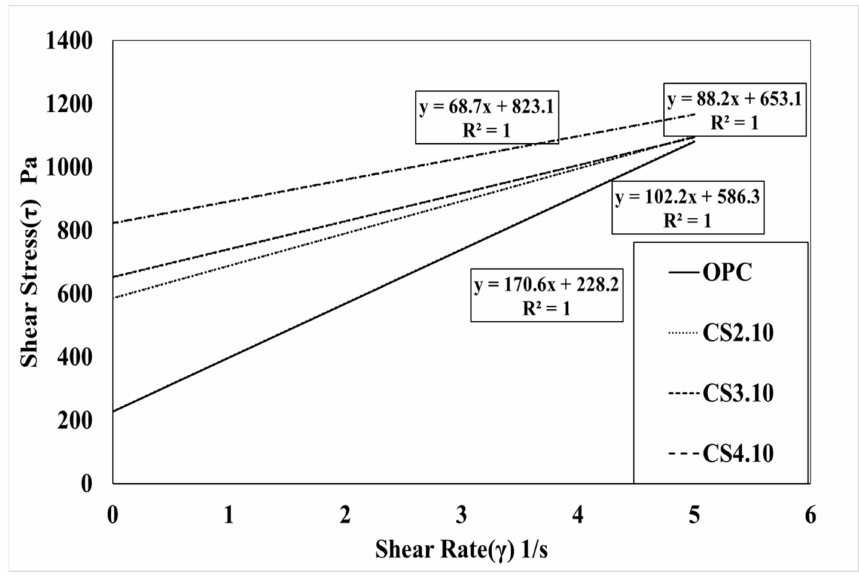
Figure 8. Bingham model results according to the mixing ratio of colloidal